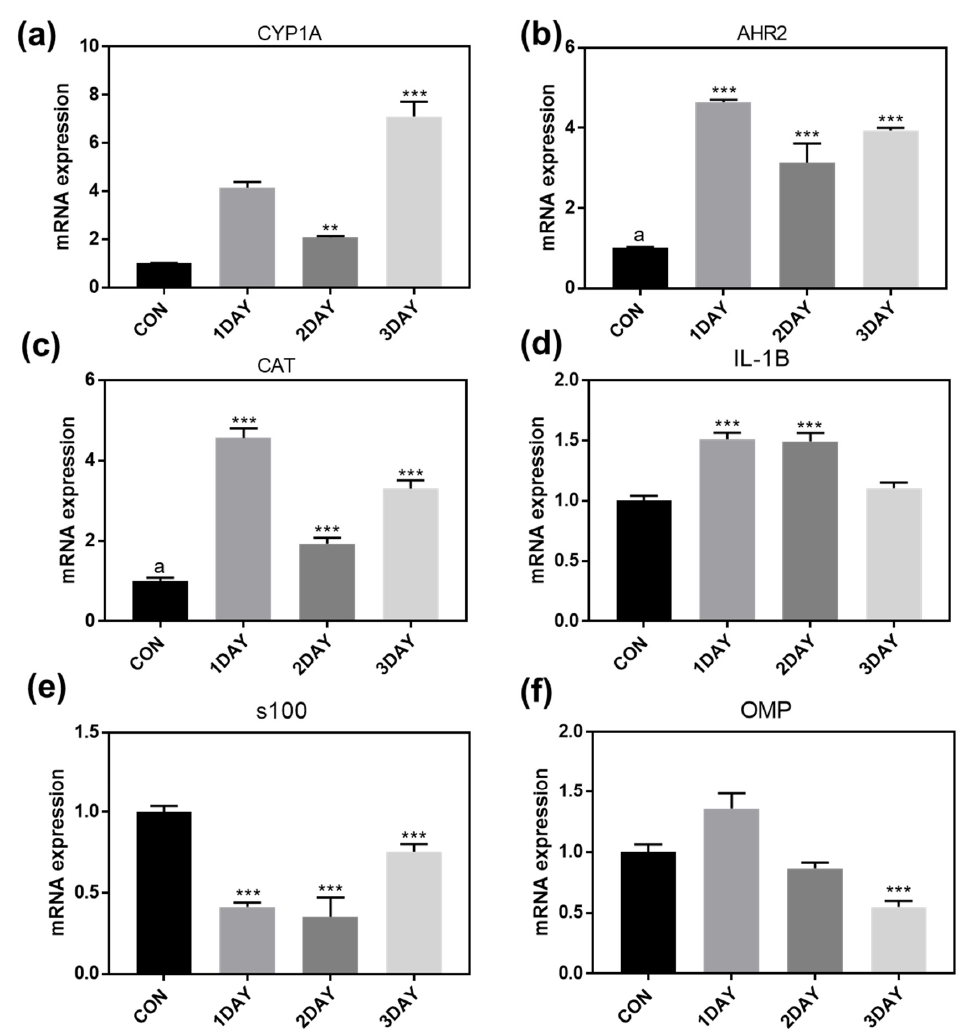
Figure 8. qRT-PCR analysis of olfactory organs of 1, 2, and 3 day KDP20 exposure. Gene expression was normalized relative to the expression of beta-actin. Expression of ( a ) CYP1A , ( b ) AHR2 , ( c ) CAT , ( d ) IL-1B , ( e ) S100 , and ( f ) OMP . Values are reported as mean ± SEM of four distinct olfactory samples. Statistical analysis by one-way ANOVA, ** p < 0.01, *** p < 0.001 versus control.